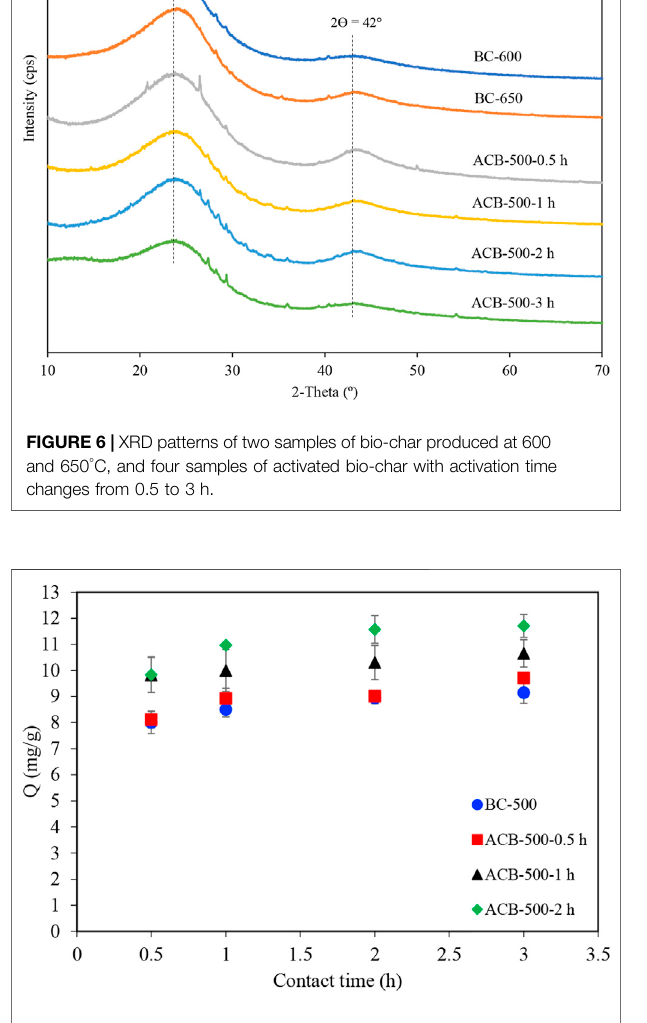
FIGURE 7 | Methylene blue adsorption pro fi les for four samples: bio- char produced at 500 ° C and three activated bio-chars produced at 900 ° C withactivationholding times of0.5, 1,and 2 h100 mlsampleswith250 mg/L of MB concentration to which 1 g of bio-char was added.